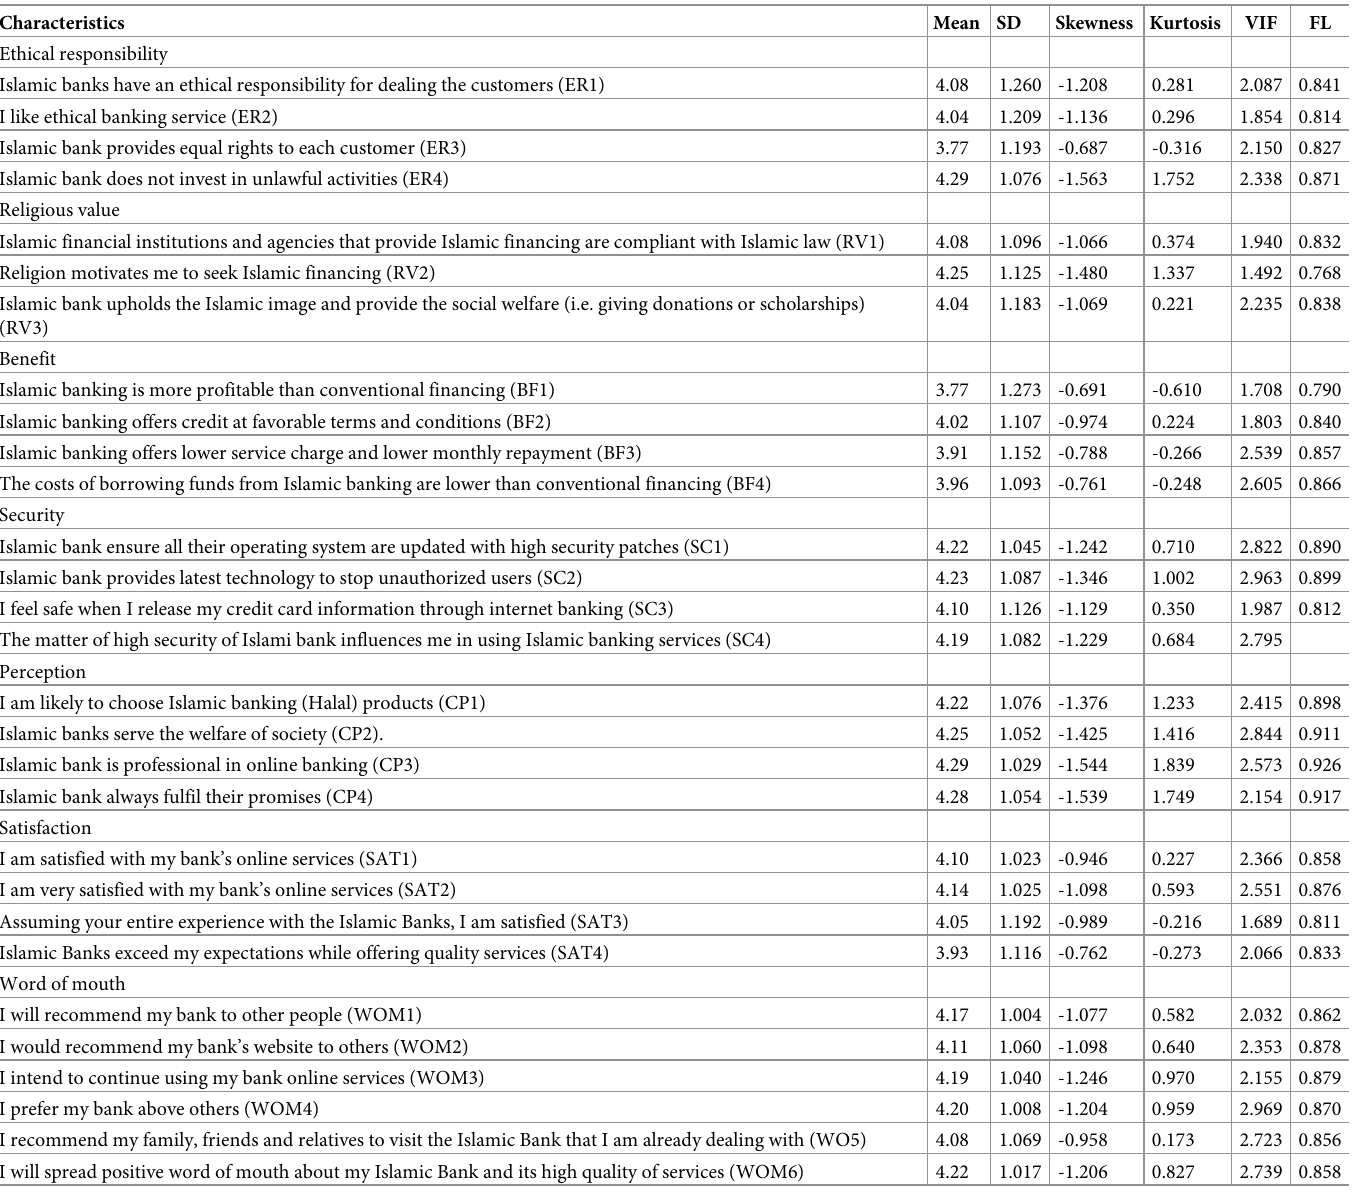
Table 2. Reliability